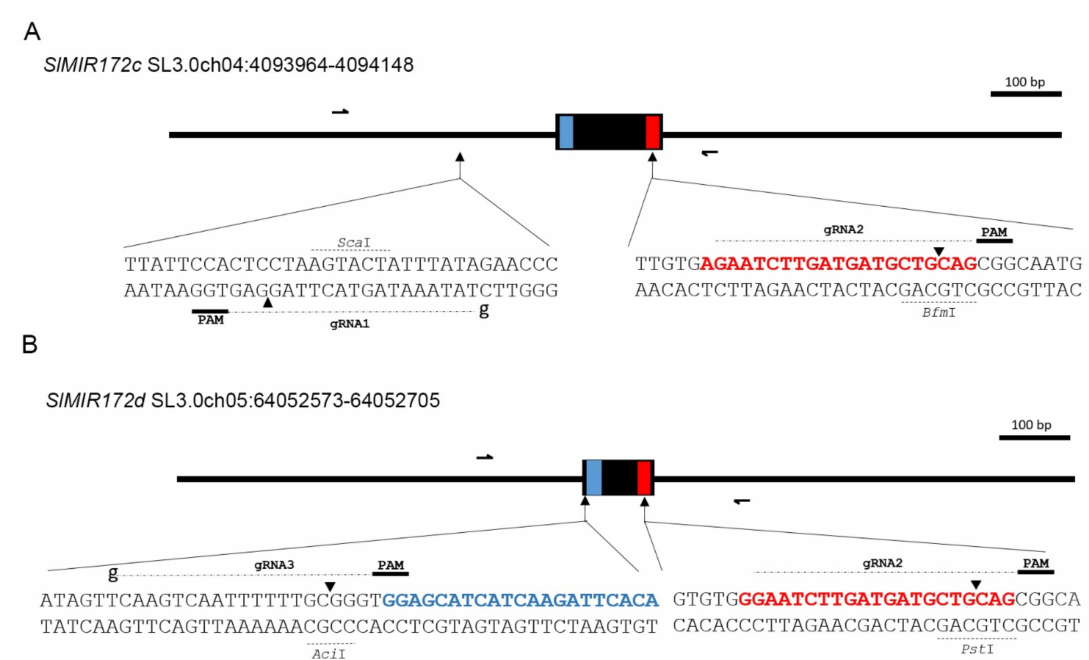
Figure 2. CRISPR/Cas9 targeting of SlMIR172c and SlMIR172d . ( A , B ) Schematic illustrations of the SlMIR172c ( A ) and SlMIR172d ( B ) gene loci. The locations of corresponding pre-miRNAs in the tomato genome are indicated. Black, red and blue boxes indicate the pre-miR172, mature sly-miR172 and miR172*, respectively. Half arrows indicate primers used for genotyping. The sequences that were targeted by Cas9 are indicated in the expanded regions. In each region, the sly-miR172 and sly-miR172* sequences are colored in red and blue, respectively, the gRNA-targeted sequences are indicated, Cas9 cleavage sites are indicated by arrowheads, the PAM sequences and restriction enzyme sites that were utilized for genotyping are